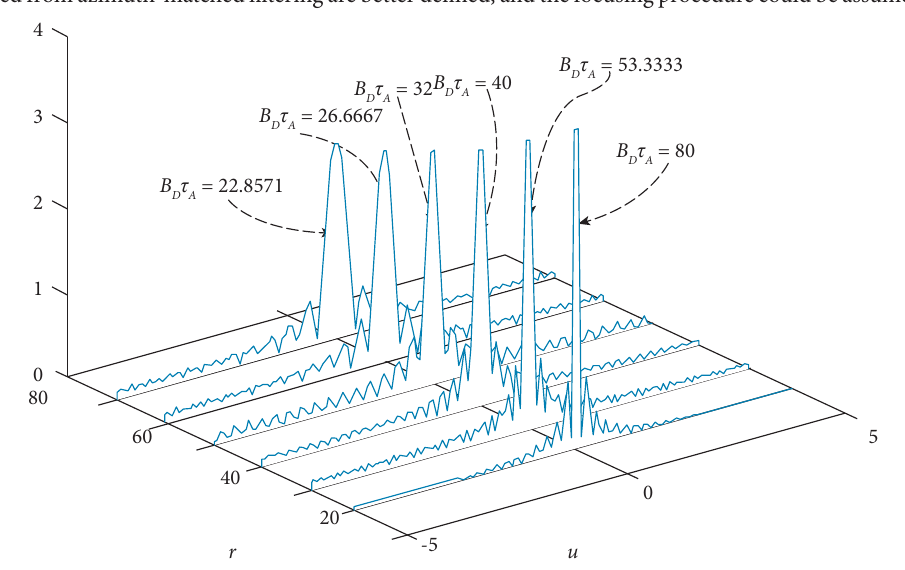
Figure 10. Sinc-like functions resulting from azimuth-matched filtering for targets located at